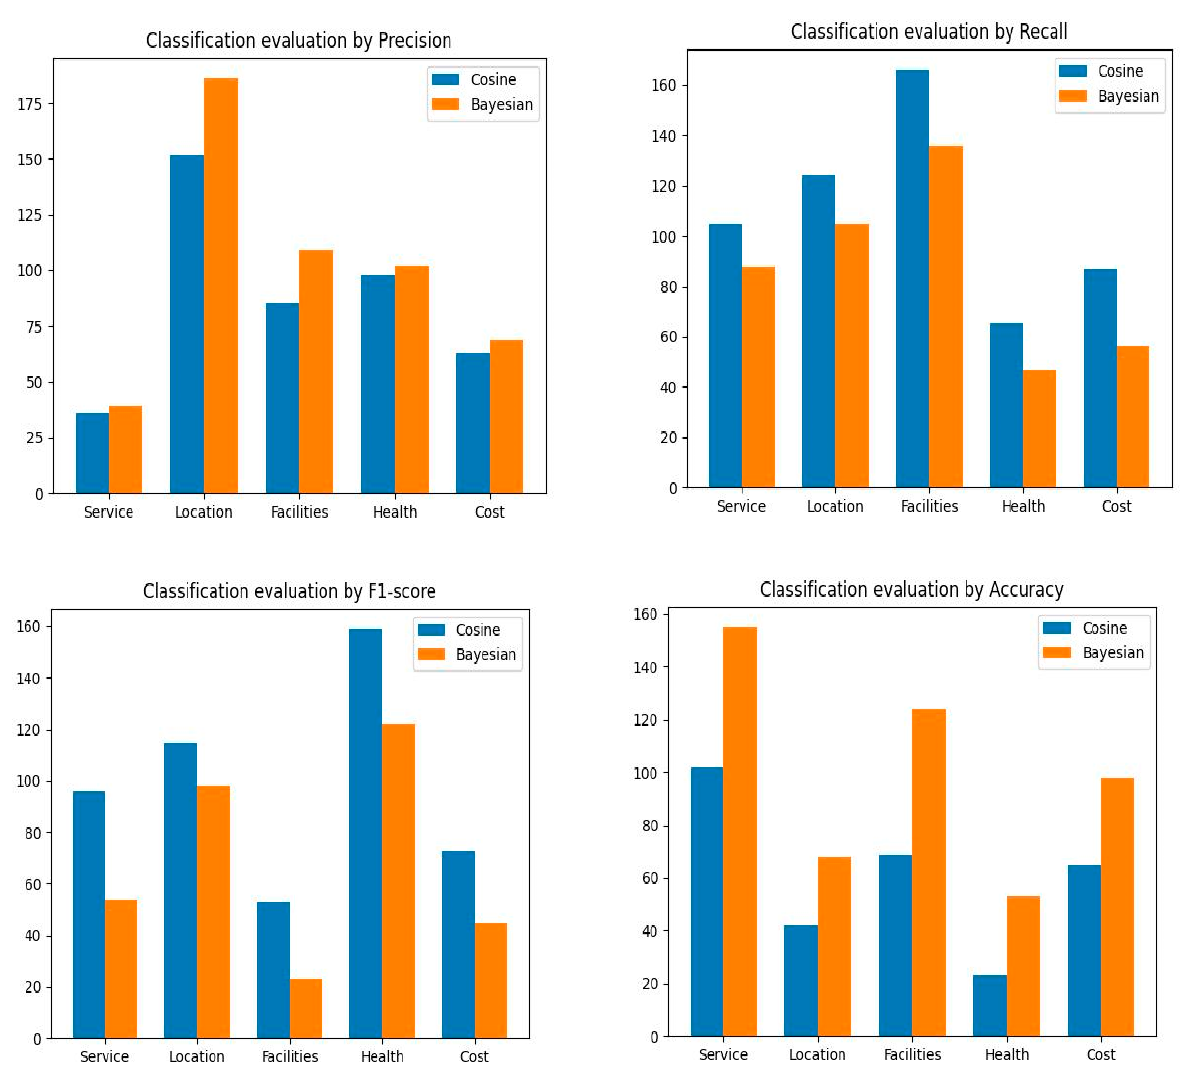
Figure 2. Accuracy, precision, recall and F1 score comparison results of two classification algo- rithms.